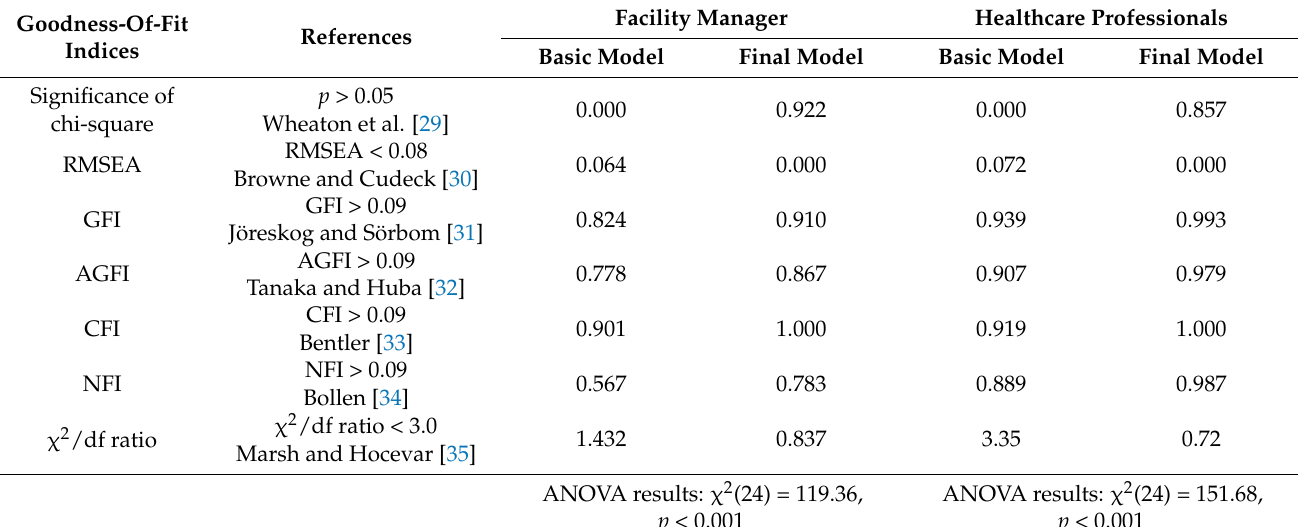
Table 5. Comparison results of goodness-of-fit indices between the basic and final models for a facility manager and healthcare